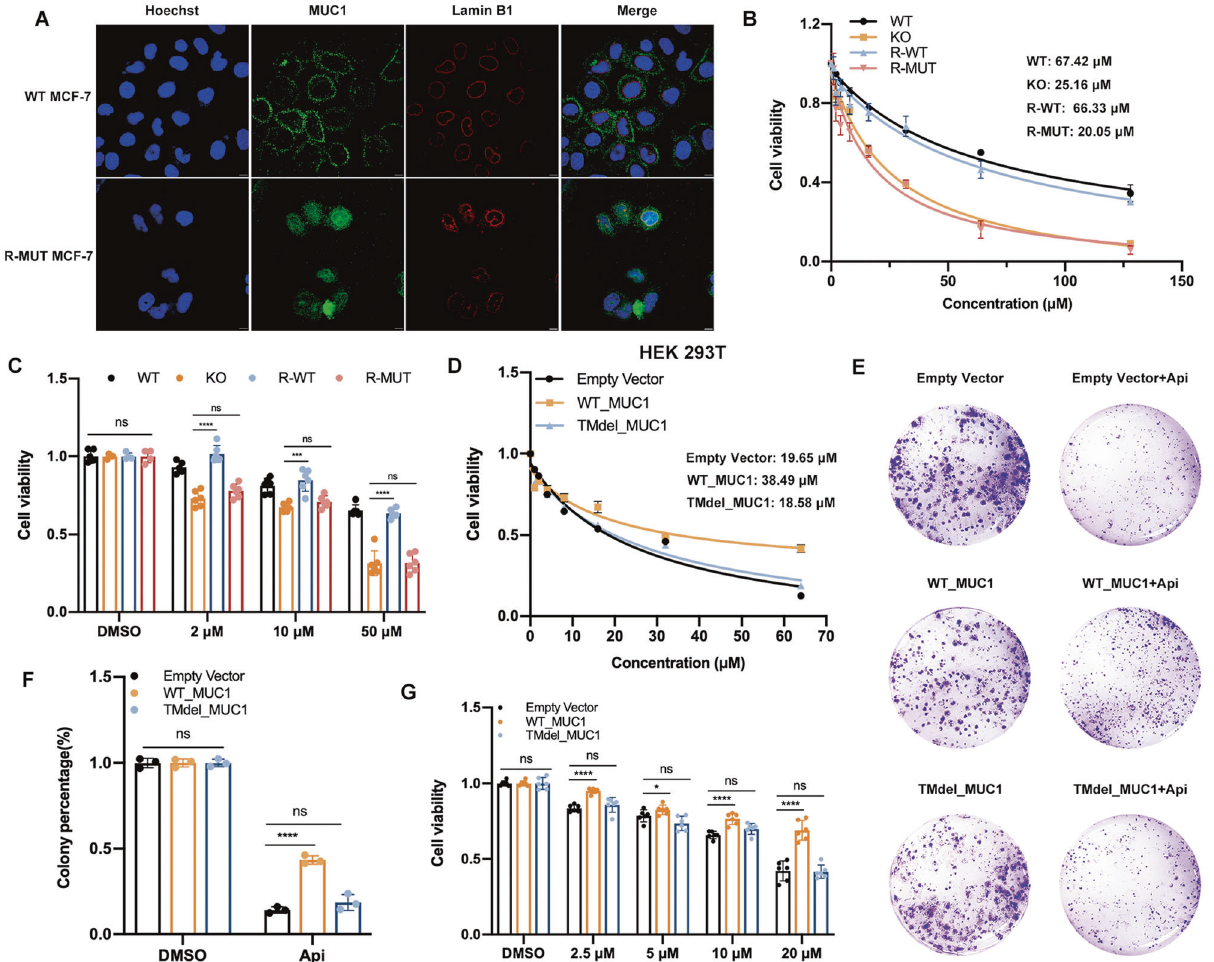
Fig. 3 The transmembrane domain was highly required for MUC1 induced drug resistance. A Immuno fl uorescence assay using MUC1 and Lamin B1 antibody was performed to con fi rm the MUC1 distribution in WT and R-MUT cells. Blue: Hoechst for nuclear staining; Red: Lamin B1 for nuclear membrane staining; Green: MUC1 staining. In WT cells, MUC1 evenly distributes on cell surface; however, the mutant MUC1 gathered in the cytoplasm and cannot anchor on cell membrane due to the TM deletion. B IC 50 of four cell lines (namely WT, KO, re-expressed WT MUC1 in KO cells (R-WT) and re-expressed mutant MUC1 in KO cells (R-MUT)) treated with various concentrations of apigenin for 48 h. C Cell viability of re-constitutively expressed MCF-7 cells treated with indicated dose of apigenin for 48 h. D IC 50 of empty vector, WT_MUC1 and TMdel_MUC1 plasmids transfected 293 T cell lines treated with various concentrations of apigenin for 48 h. E Colony formation of empty vector, WT_MUC1 and TMdel_MUC1 plasmids transfected 293 T cell lines treated with 25 μ M apigenin for a week. F The quanti fi cation of E.